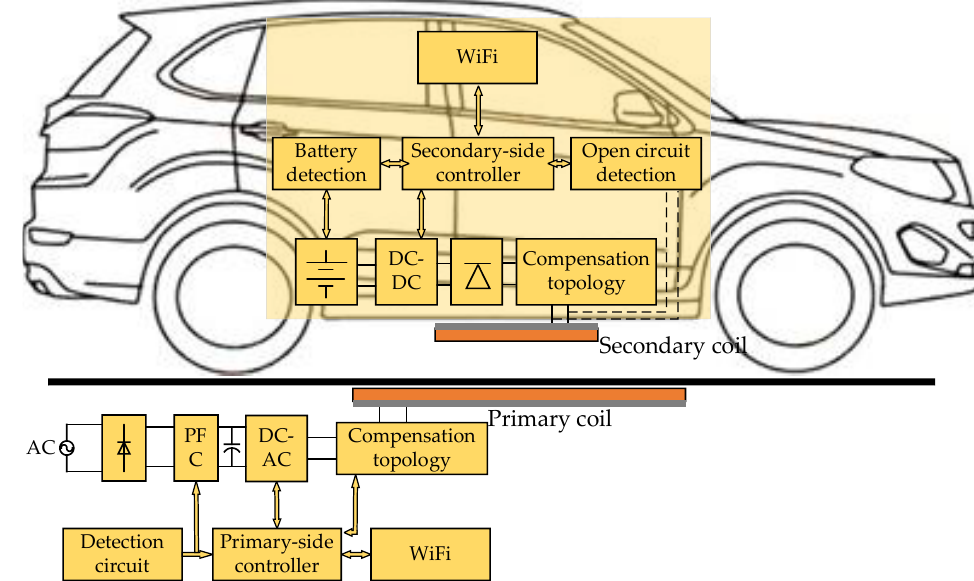
Figure 1. Composition of EV wireless chargers.